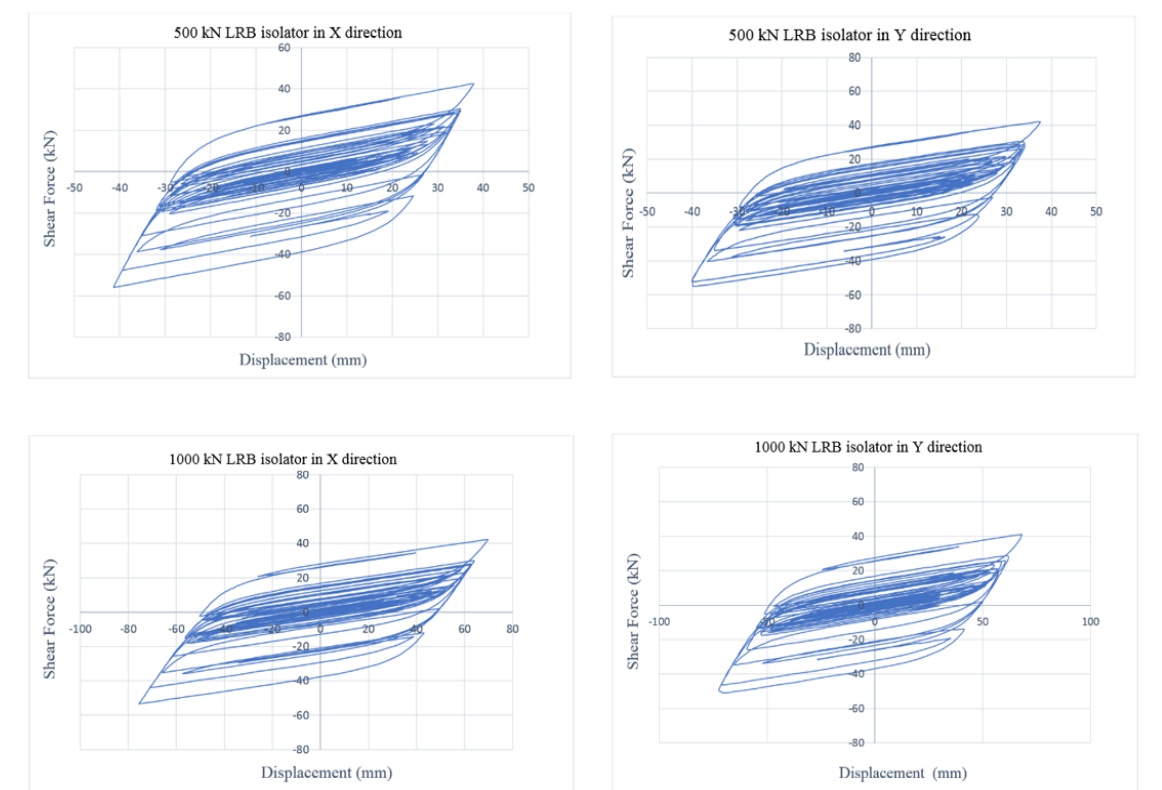
Figure 6. The hysteretic cycles of LRB isolators with 500 and 1000 kN vertical loads for seismic actions in the X and Y directions.